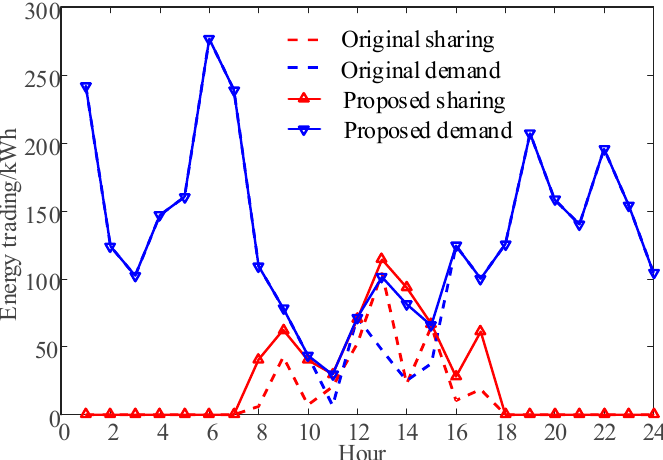
Figure 10. Comparison of energy trading in the energy market.